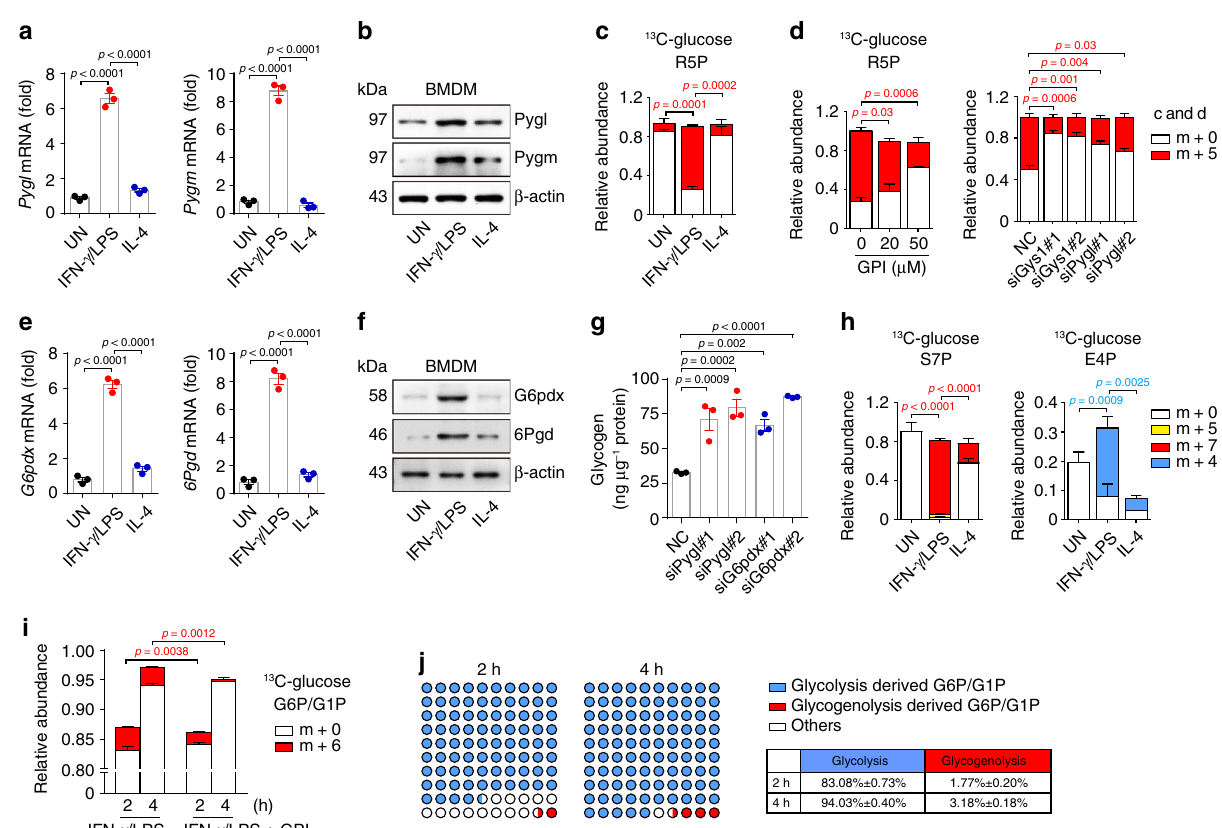
Fig. 2 Glycogenolysis-derived G6P is channeled to the PPP. a , b Pygl and Pygm expression in untreated, IFN- γ /LPS or IL-4 treated BMDMs were determined by real-time PCR ( a ) and western blot ( b ). c BMDMs differentiated in normal 12 C-glucose were stimulated with IFN- γ /LPS or IL-4 for 6 h and switched to 13 C-glucose for 6 h, LC-MS/MS was performed for m + 5-labeled R5P. d BMDMs were pretreated with GPI for 30 min or pretransfected with siRNA ( Gys1 or Pygl ) for 24 h prior to stimulation with IFN- γ /LPS for 6 h and switched to 13 C-glucose for 6 h, LC-MS/MS was performed for m + 5-labeled R5P. e , f G6pdx and 6Pgd expression in untreated, IFN- γ /LPS or IL-4 treated BMDMs were determined by real-time PCR ( e ) and western blot ( f ). g Pygl or G6pdx siRNA transfected BMDMs were stimulated with IFN- γ /LPS for 36 h. Intracellular glycogen levels were detected by colorimetric assay. h BMDMs differentiated in normal 12 C-glucose were stimulated with IFN- γ /LPS or IL-4 for 6 h and switched to 13 C-glucose for 6 h, LC-MS/MS was performed for m + 7-labeled S7P, m + 5-labeled S7P and m + 4-labeled E4P. i , j BMDMs cultured and differentiated in 13 C-glucose were pretreated with GPI for 30 min prior to stimulation with IFN- γ /LPS for 6 h and switched to 12 C-glucose for 2 or 4 h, 13 C-labeled G6P/G1P were detected by LC-MS/MS ( i ). The ratio of G6P/G1P from glycogenolysis or glycolysis was calculated. The glycogenolysis-derived G6P using the format of [m + 6 G6P (IFN- γ /LPS) – m + 6 G6P (IFN- γ /LPS + GPI)]/Total G6P (IFN- γ /LPS) and the glycolysis-derived G6P by the format of [m + 0 G6P (IFN- γ /LPS)] / Total G6P (IFN- γ /LPS) ( j ). Unless otherwise speci fi ed, n = 3 biologically independent experiments were performed. Data are presented as mean ± SEM. P values were calculated using one- way